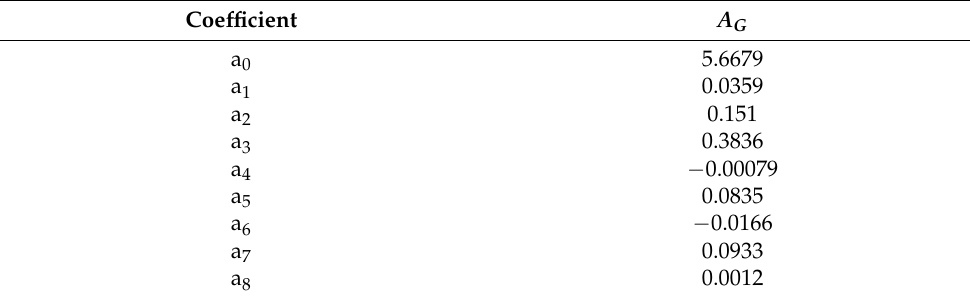
Table 6. The vector A G coefficients for an extended model.